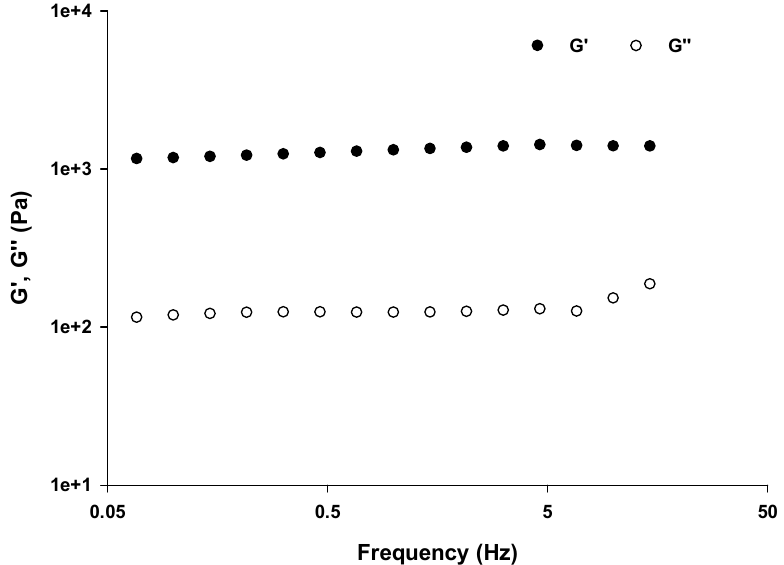
Figure 3. G’ and G” extracted from the frequency sweep experiments at a constant frequency of 1 Hz for the medium HEC100, representative of all media. G’: storage (elastic) modulus; G”: loss (viscous) modulus; HEC: hydroxyethyl cellulose; 100: 100 mg L − 1 .